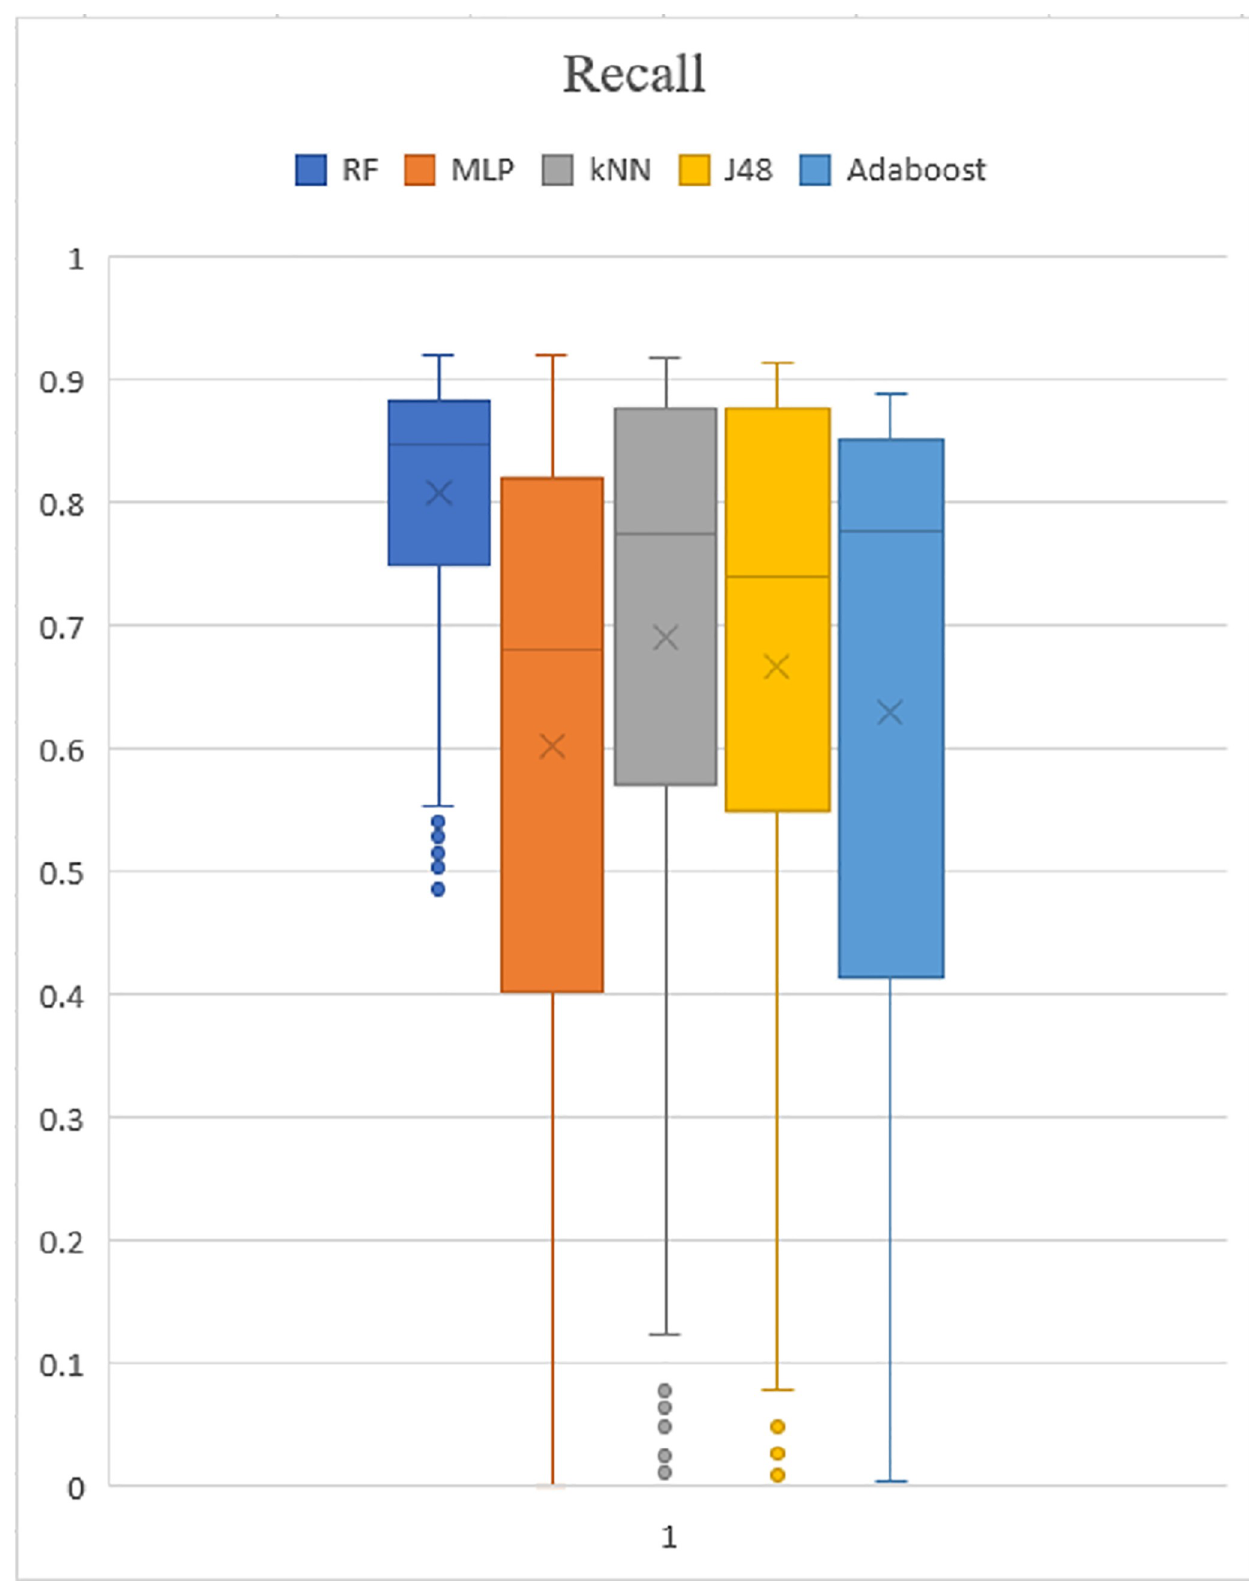
Fig 10. Recall. https://doi.org/10.1371/journal.pone.0257968.g010 PLOS ONE | https://doi.org/10.1371/journal.pone.0257968 September 30,